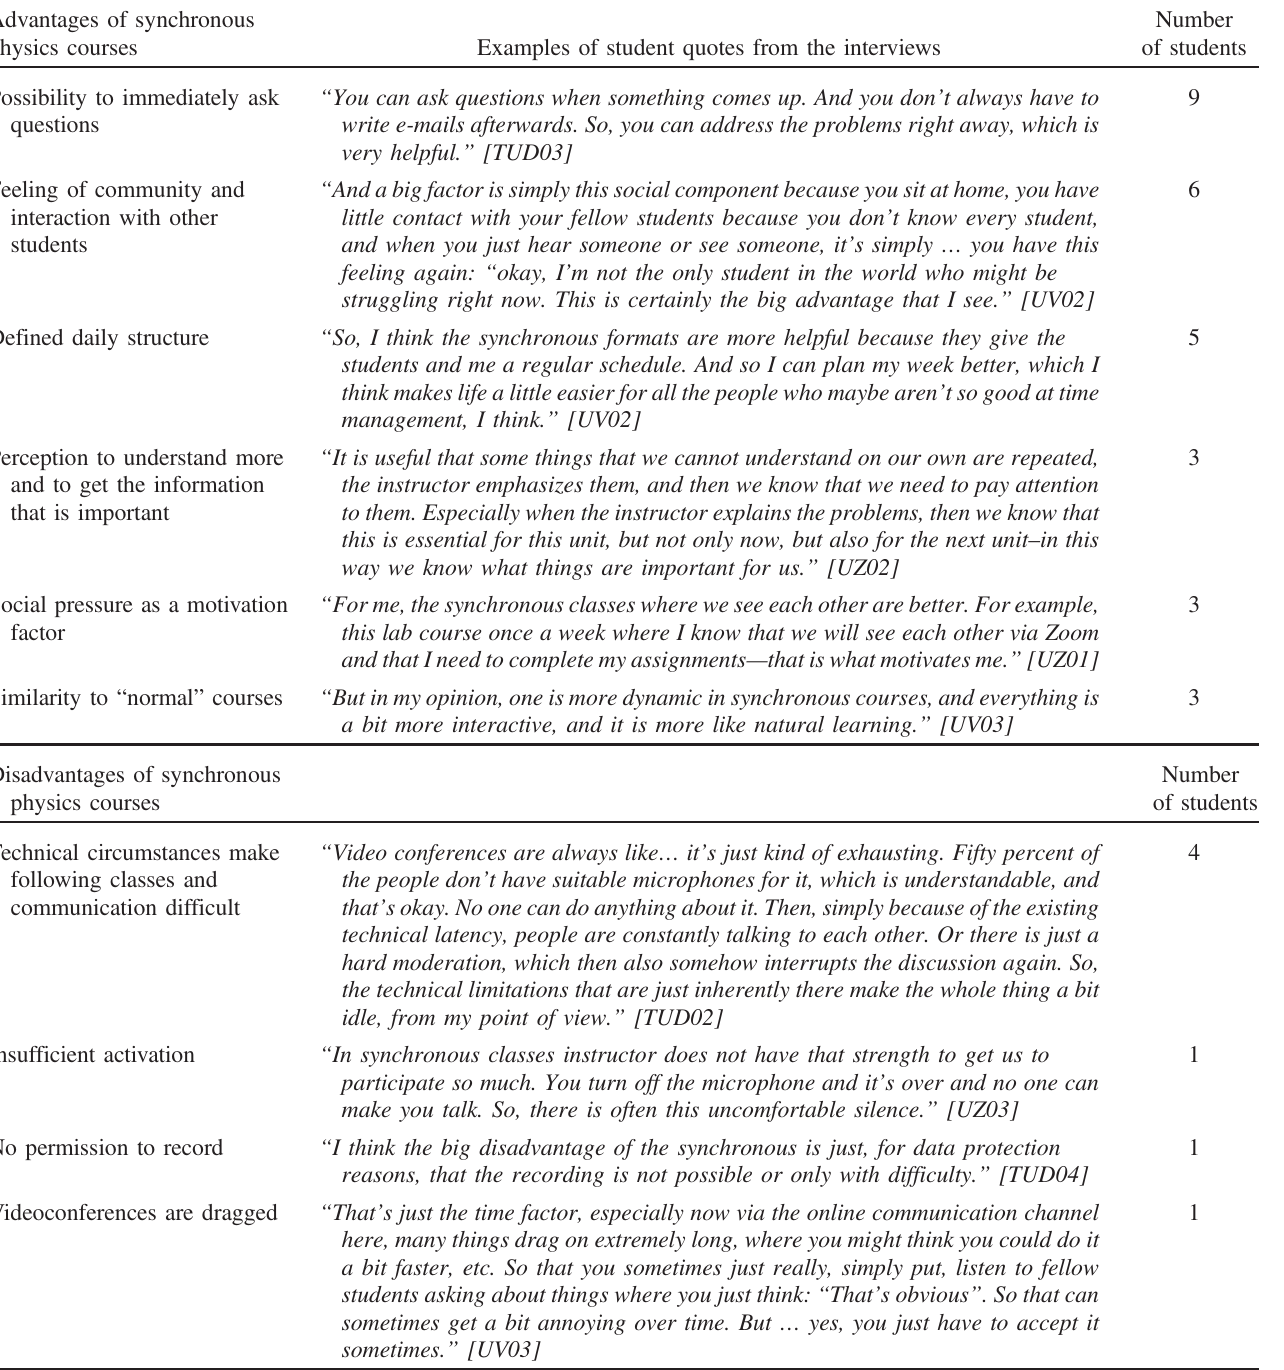
TABLE V. Advantages and disadvantages of synchronous physics